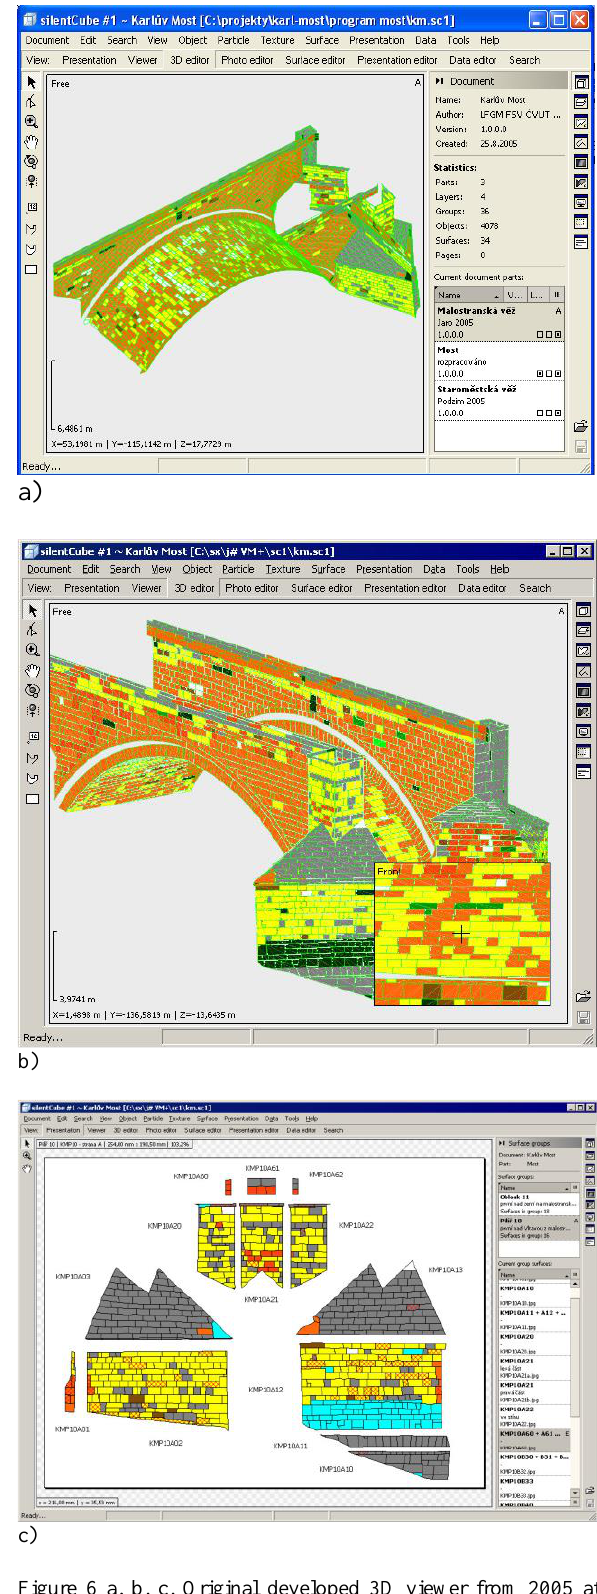
Figure 6 a, b. c. Original developed 3D viewer from 2005 at CTU in Prague, FCE might be called 3D GIS or the predecessor of